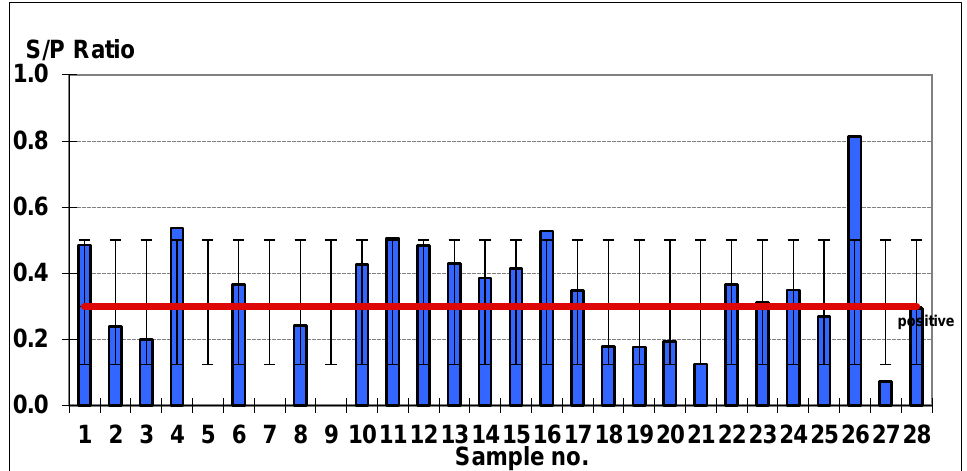
Figure 2. S/P ratios of 0.3 and above were considered cut-off values for positive samples. Fifteen out of twenty-eight serum samples were positive.